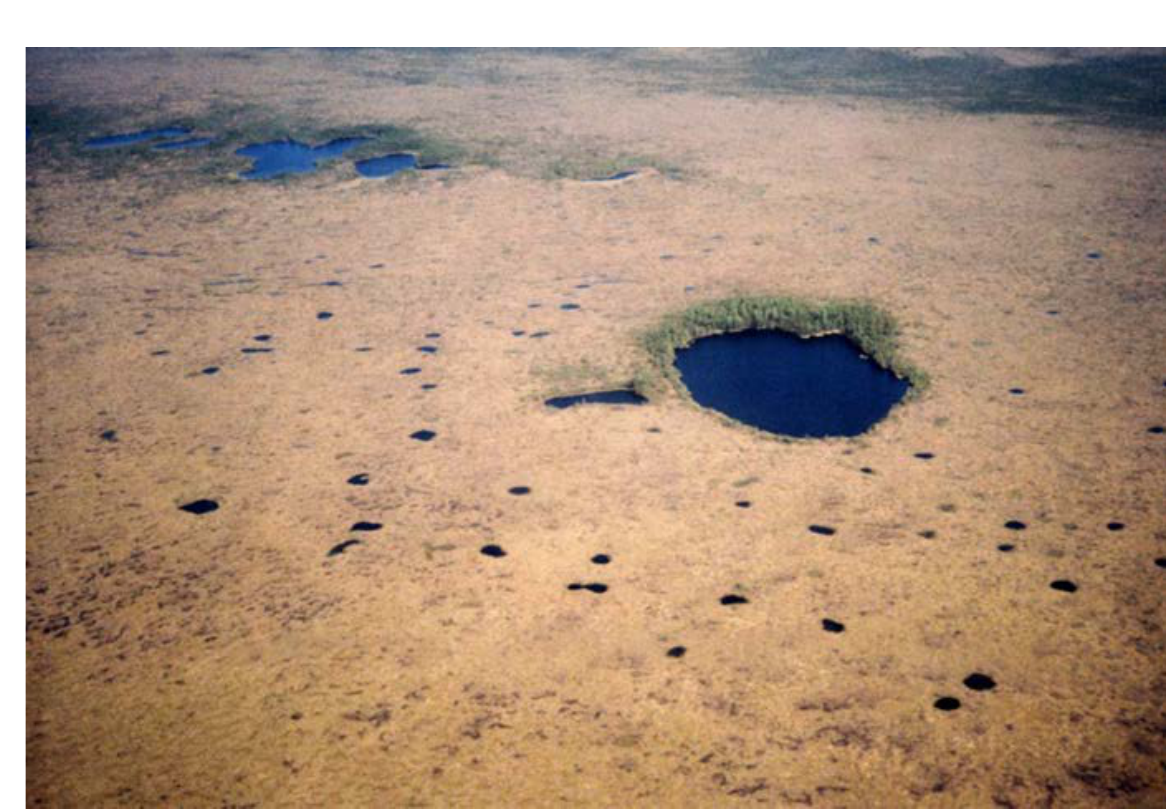
Figure 2. An aerial photograph of the Yelnia peat bog (photo: V.